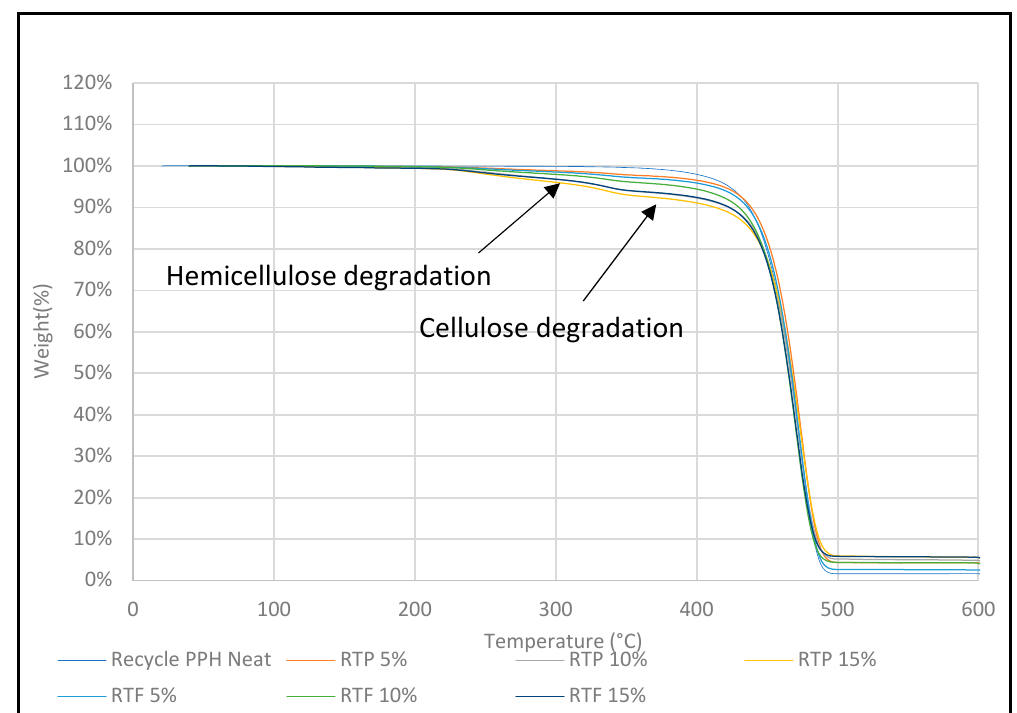
Figure 12. TGA of recycled homo polypropylene-treated fiber composites.